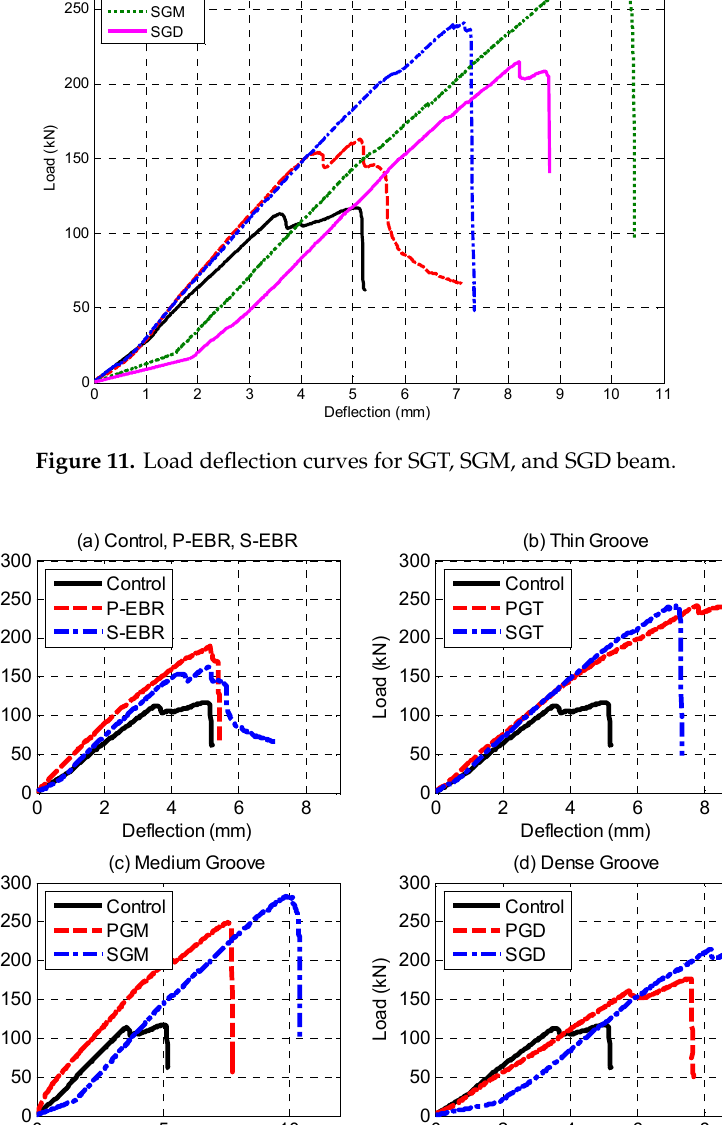
Figure 12. Load-deflection curves: ( a ) Control, P-EBR, S-EBR; ( b ) Thin grooves; ( c ) Medium grooves; ( d ) Dense grooves.